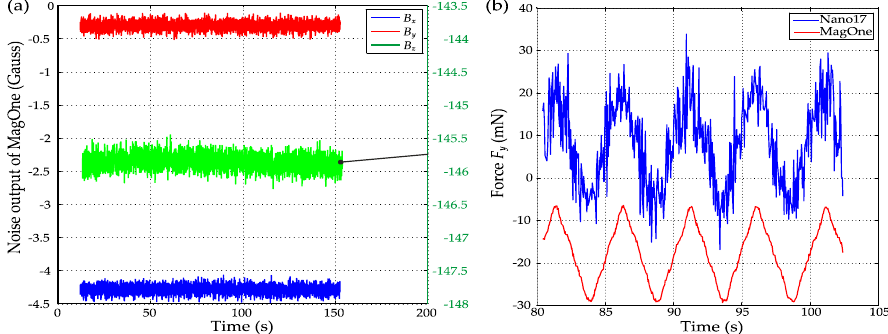
Figure 13. ( a ) Noise of the MagOne output (unloaded); ( b ) Shear force measurement comparison of MagOne and Nano17.